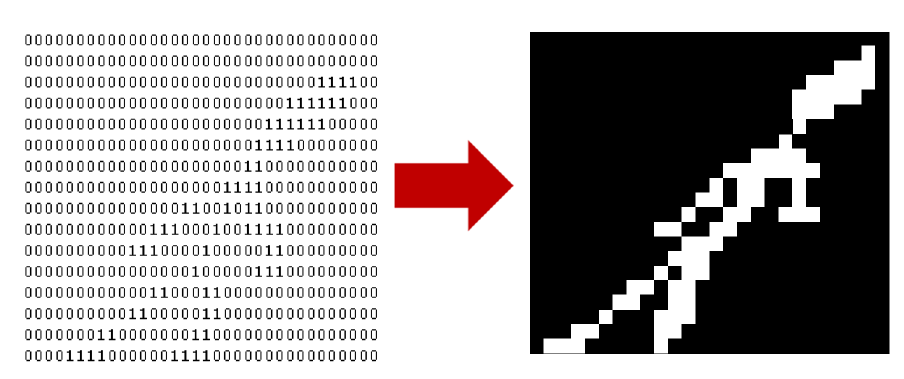
Figure 3. Resulting binary matrix data and silhouette from an object passing through the N-IR beams of a custom array profiling